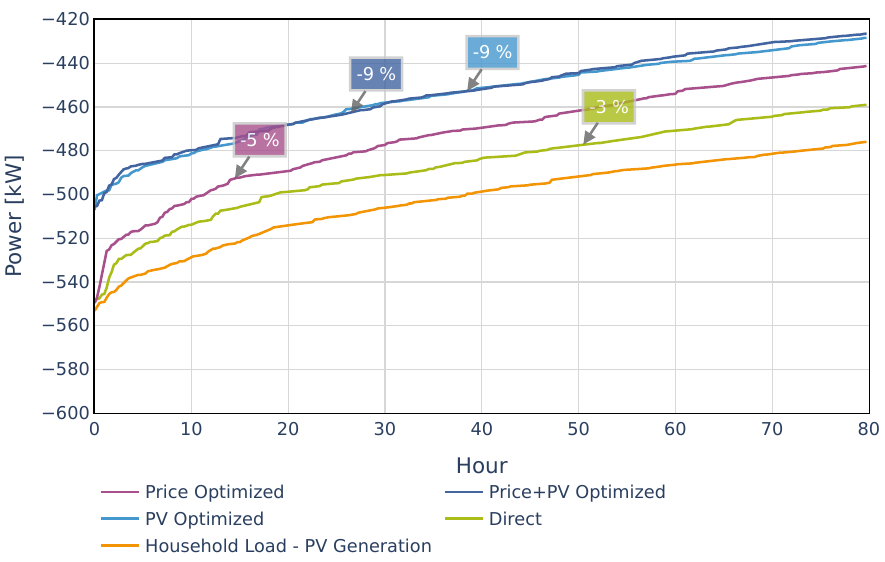
Figure 20. Largest 1% of minimum values of sorted grid load for each charging configuration against household load. Annotations show the increase of grid load compared to household